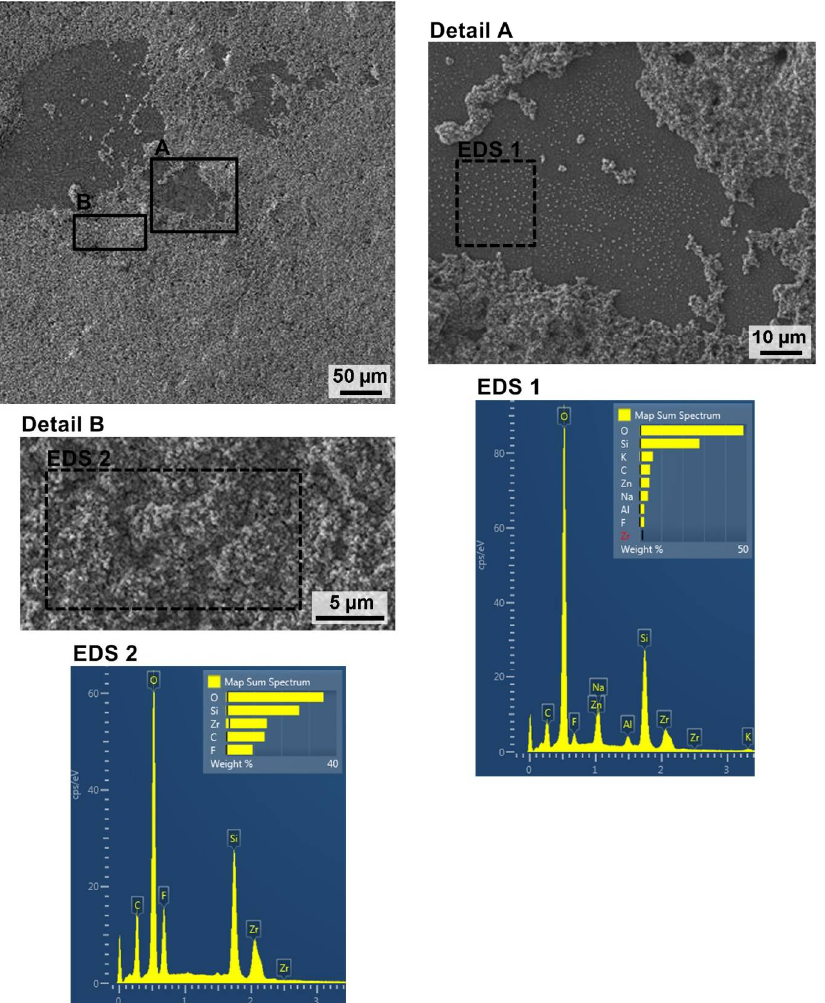
Figure 3. Image of the sample surface after Alfipas 7818 (SEM), detail ( A ) shows a surface on